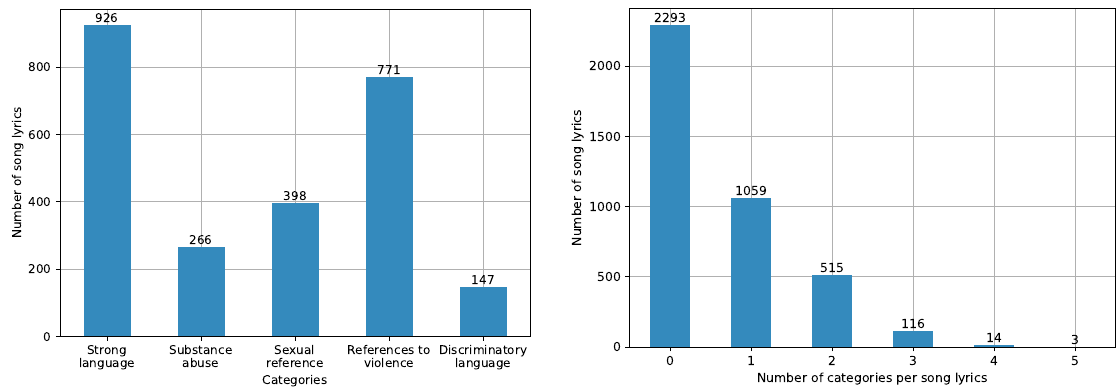
Figure 1. Number of song lyrics annotated for each of the considered categories ( left ); distribution of the song lyrics based on the number of categories they were annotated with ( right ).